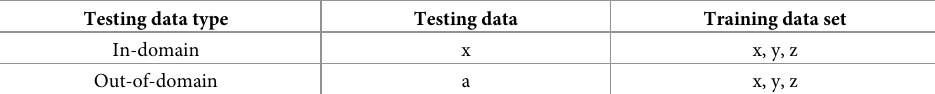
Table 1. The Detailed experiment introduction and classification. (a,x,y and z represent a set of statements for a par- ticular